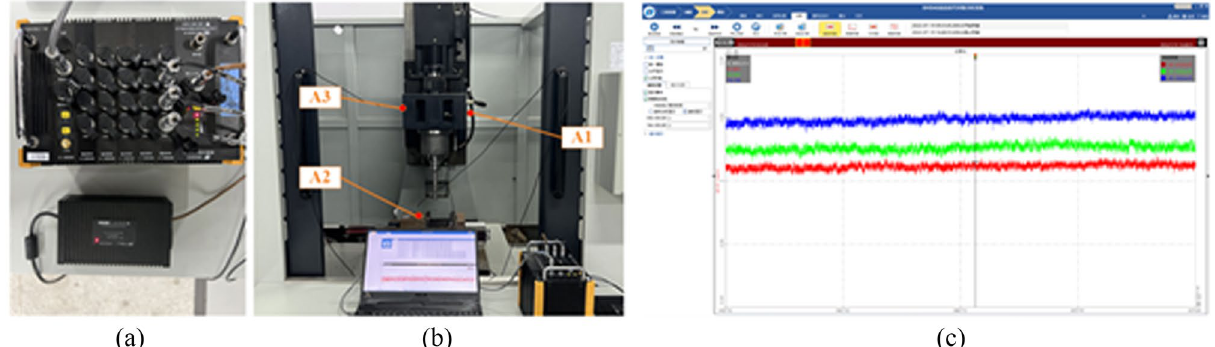
Figure 14. Vibration information acquisition experiment of machine